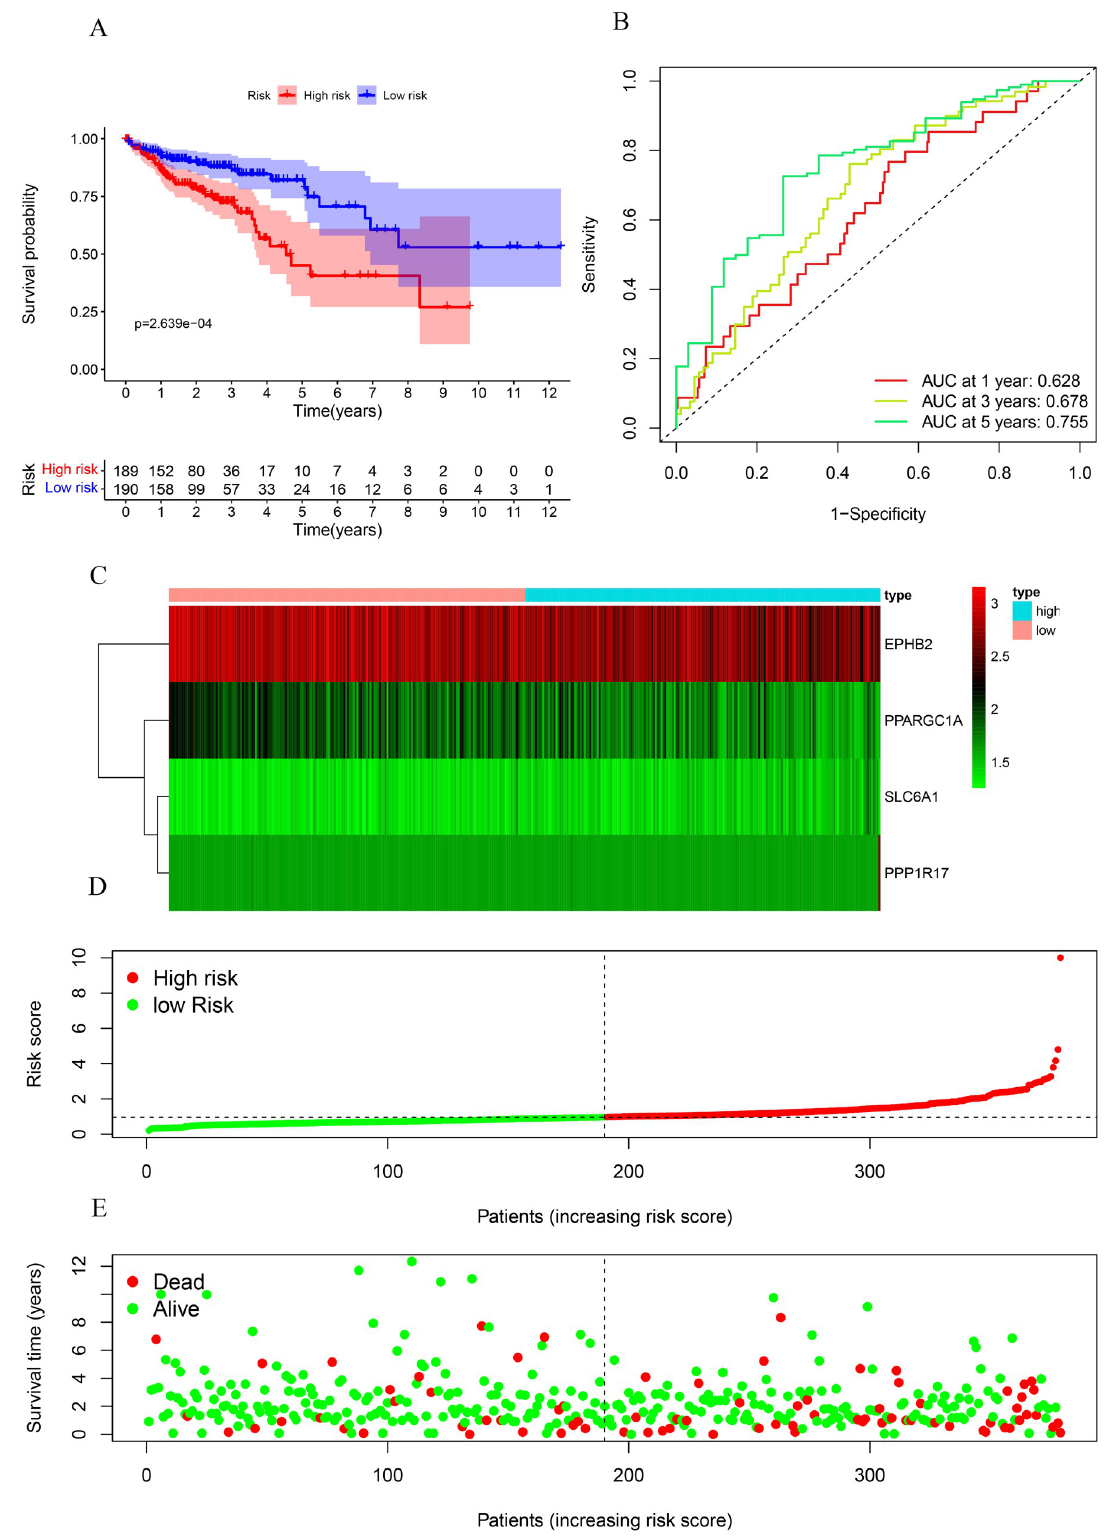
Fig 5. Risk score analysis of the four-gene prognostic model in the TCGA cohort. (A) Survival curve for low- and high-risk groups. (B) ROC curves for prediction of overall survival based on the risk score. (C,D,E) Expression heat map, risk score distribution, and survival